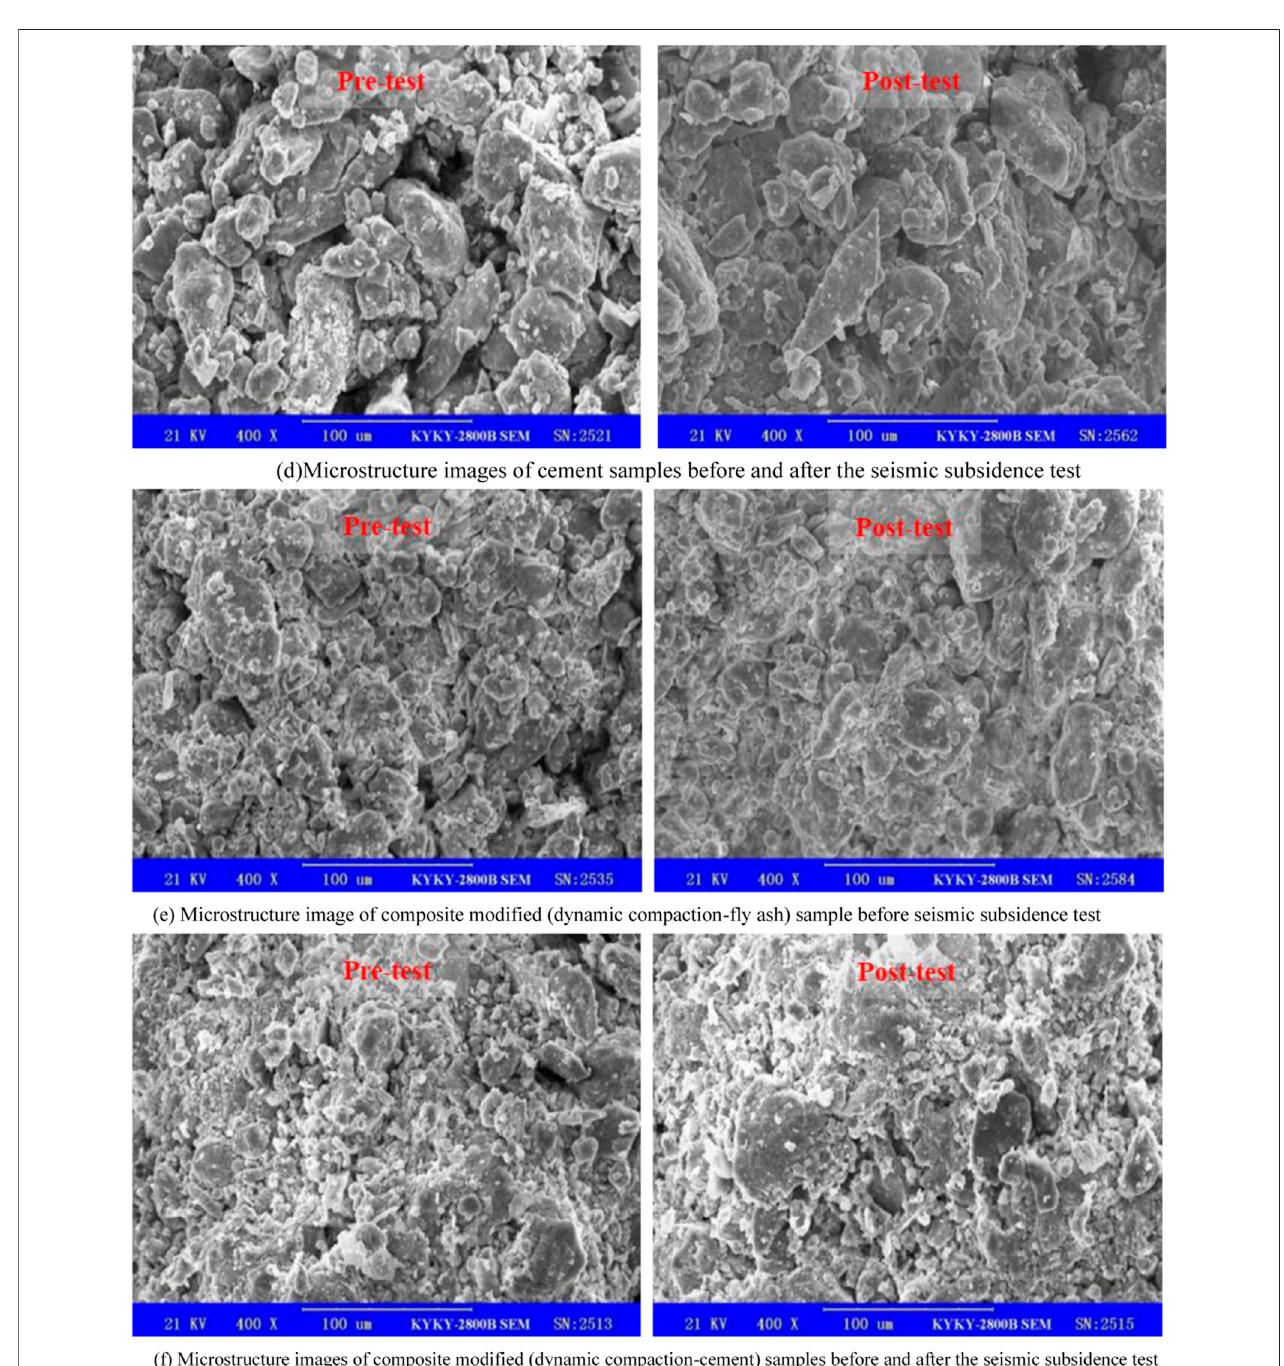
FIGURE2| Microstructure image ofsamplesbefore and after theseismic subsidence test. (A) Microstructureimage oftheundisturbed specimen before and after theseismicsubsidencetest. (B) Microstructureimagesofthedynamiccompactionsamplebeforeandaftertheseismicsubsidencetest. (C) Microstructureimagesof fl y ashsamplesbeforeandaftertheseismicsubsidencetest. (D) Microstructureimagesofcementsamplesbeforeandaftertheseismicsubsidencetest. (E) Microstructure image of composite modi fi ed (dynamic compaction – fl y ash) sample before seismic subsidence test. (F) Microstructure images of composite modi fi ed (dynamic compaction – cement) samples before and after the seismic subsidence test.